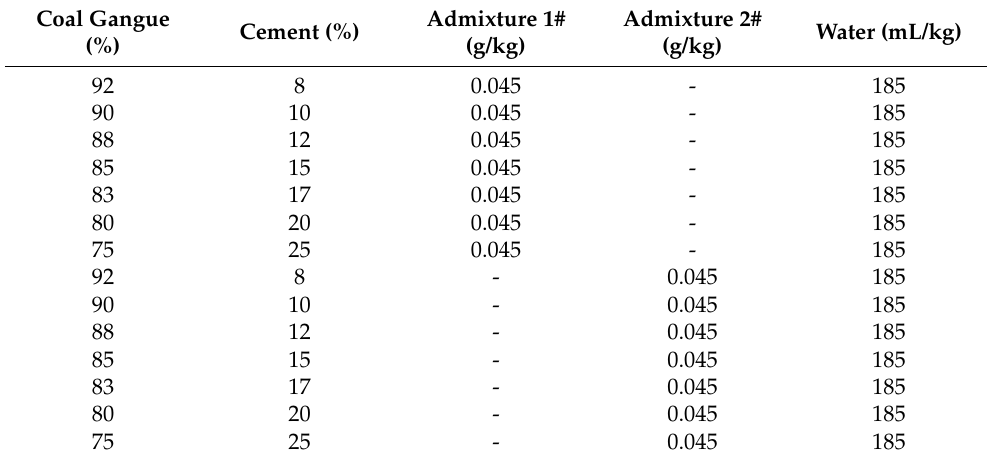
Table 4. The incorporation amount of gangue as well as the base ratio of different types of admixture. Coal